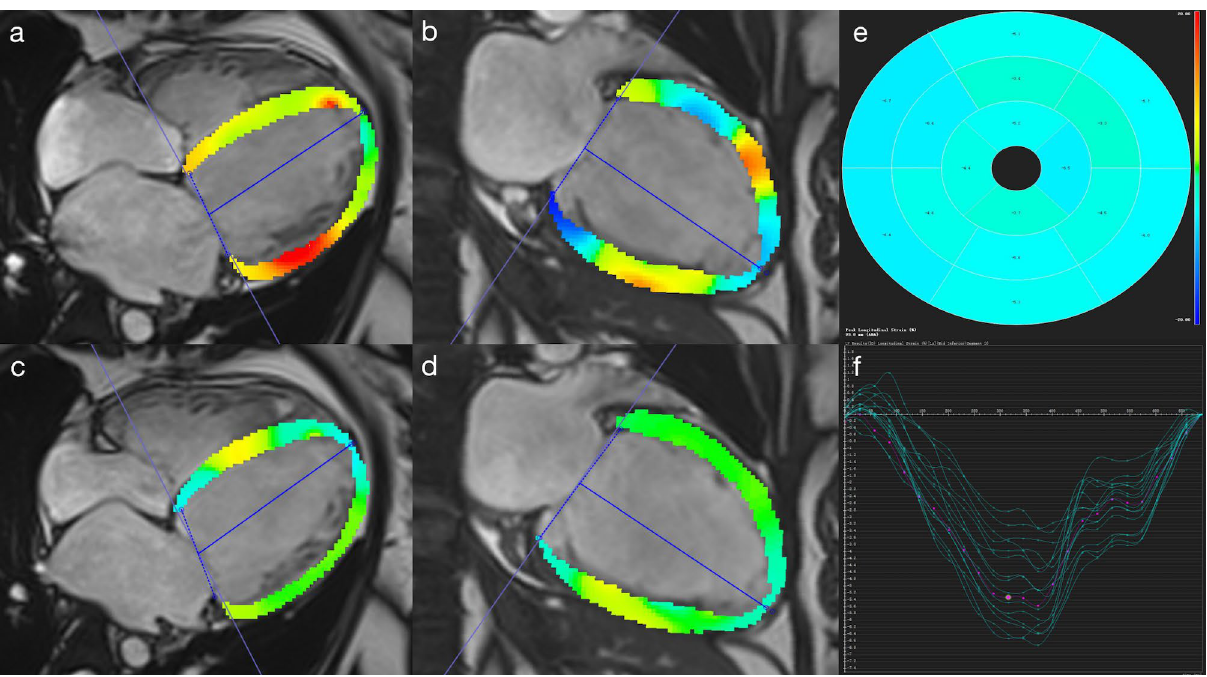
Figure 4. Represent case of global peak longitudinal strain reduction in LVNC combined with MR at the end-systole (a,b) and end-diastole (c,d) . (a–d) General reduction (coloration from light blue to light green) of peak longitudinal strain (absolute value). (e–f) The absolute value of global peak longitudinal strain showed significantly reduced.